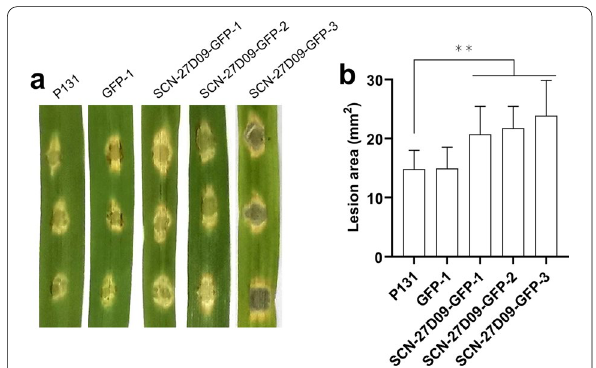
Fig. 4 Heterologous expression of SCN-27D09 in Magnaporthe oryzae enhances the virulence of the fungus. a Symptoms on detached barley leaves inoculated with spore suspensions (5 mL) of the wild-type M. oryzae P131 strain or transformants at 5 dpi. b Lesion area on barley leaves shown in a . Data are means deviation. N 3 ( t test between SCN-27D09-GFP and control values; = * P < 0.05, ** P <